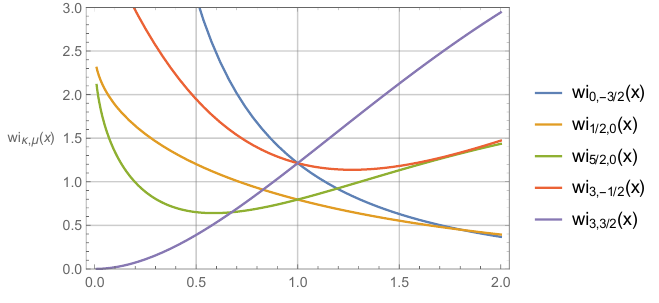
Figure 6. The integral Whittaker functions wi κ , µ ( x ) as a function of variable x at fixed values of parameters κ and µ